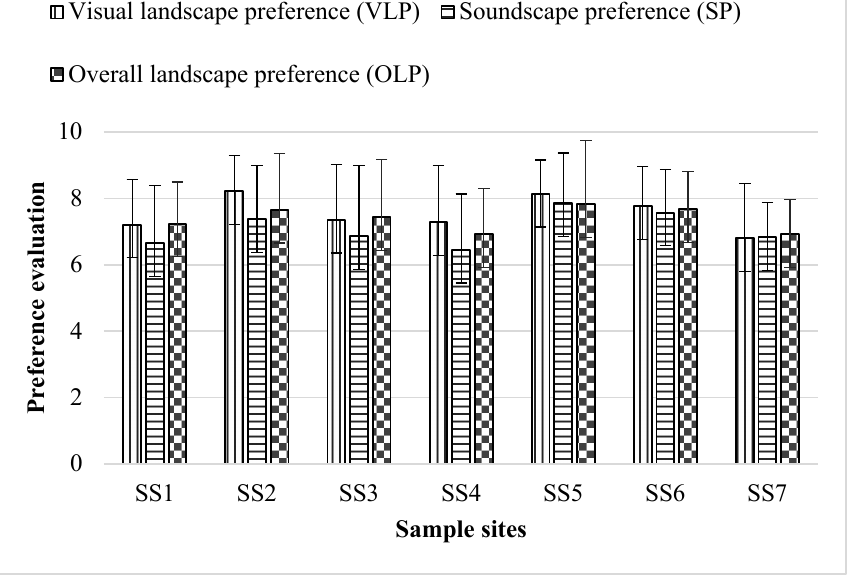
Figure 4. Evaluation on park landscape preference. Table 3. Correlation analysis between VLP, SP, and OLP